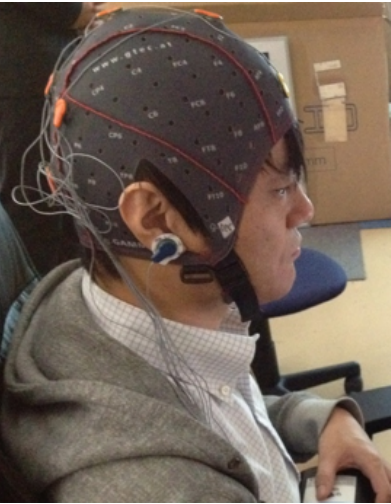
Figure 1. The most widely used method for recording brain activity in brain–computer interfacing is EEG, as it is a technique that is simple, noninvasive, portable, and cost-effective. Typical electroen- cephalogram recording setup: cap carrying on contact electrodes and wires (from the Department of Electrical and Electronic Engineering at the Tokyo University of Agriculture and Technology). The wires are connected to amplifiers that are not shown in the figure. Amplifiers also improve the quality of acquired signals through filtering. Some amplifiers include analog-to-digital converters to allow brain signals to be acquired by (and stored on) a